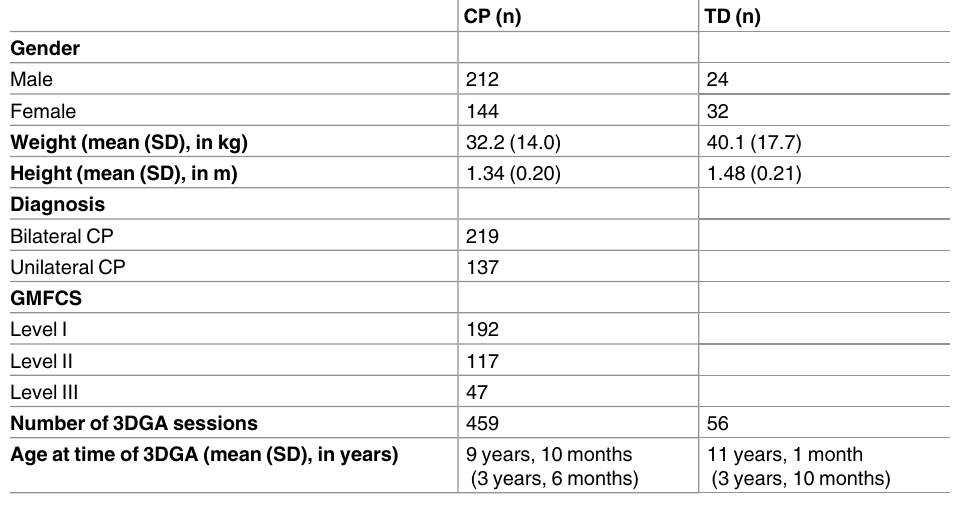
Table 2. Demographic characteristics of CP (n = 356) and TD (n = 56)